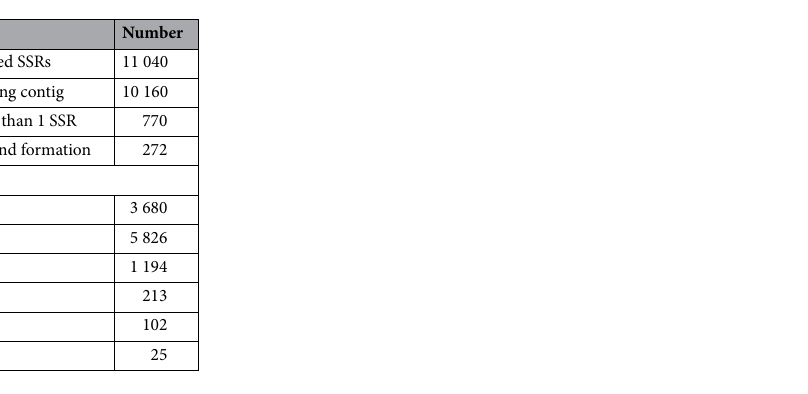
Table 3. Number of microsatellite regions observed in M. casturi scaffolds, total and subdivided by motif.